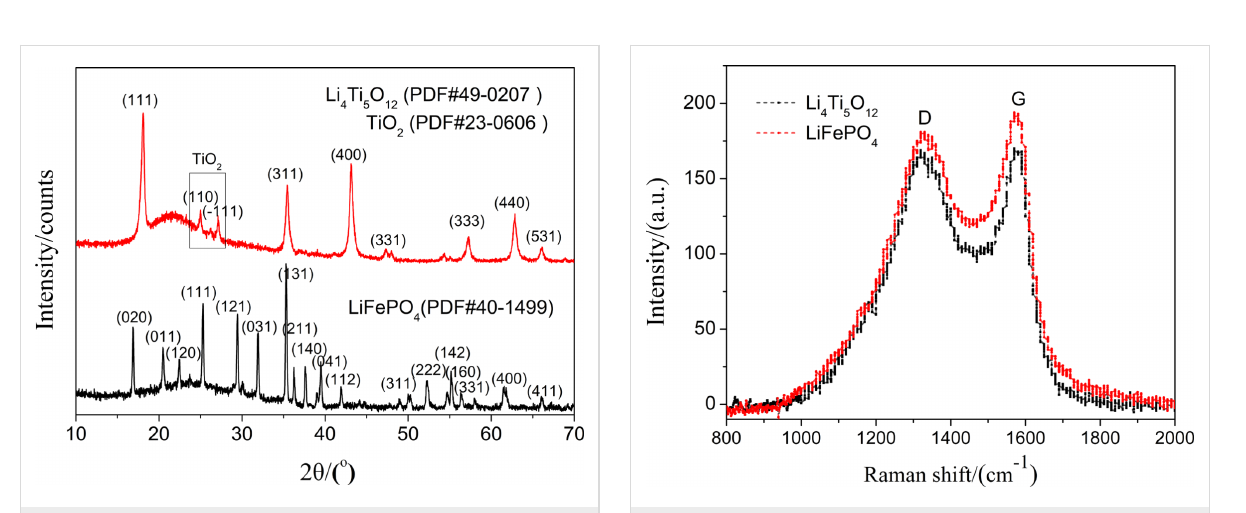
two characteristic peaks at 1350 cm − 1 and 1580 cm − 1 corre- sponding to the D and the G band of carbon, respectively. The ratio of the two peaks reflects the degree of graphitization. This